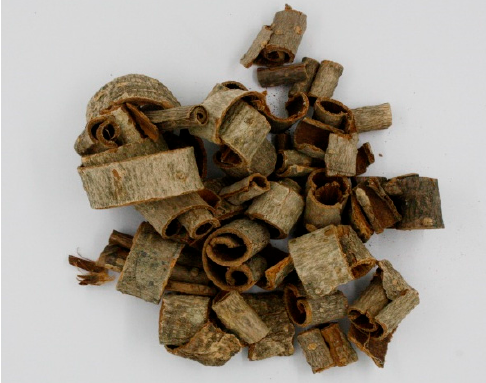
Figure 6. The sample of M. officinalis bark.